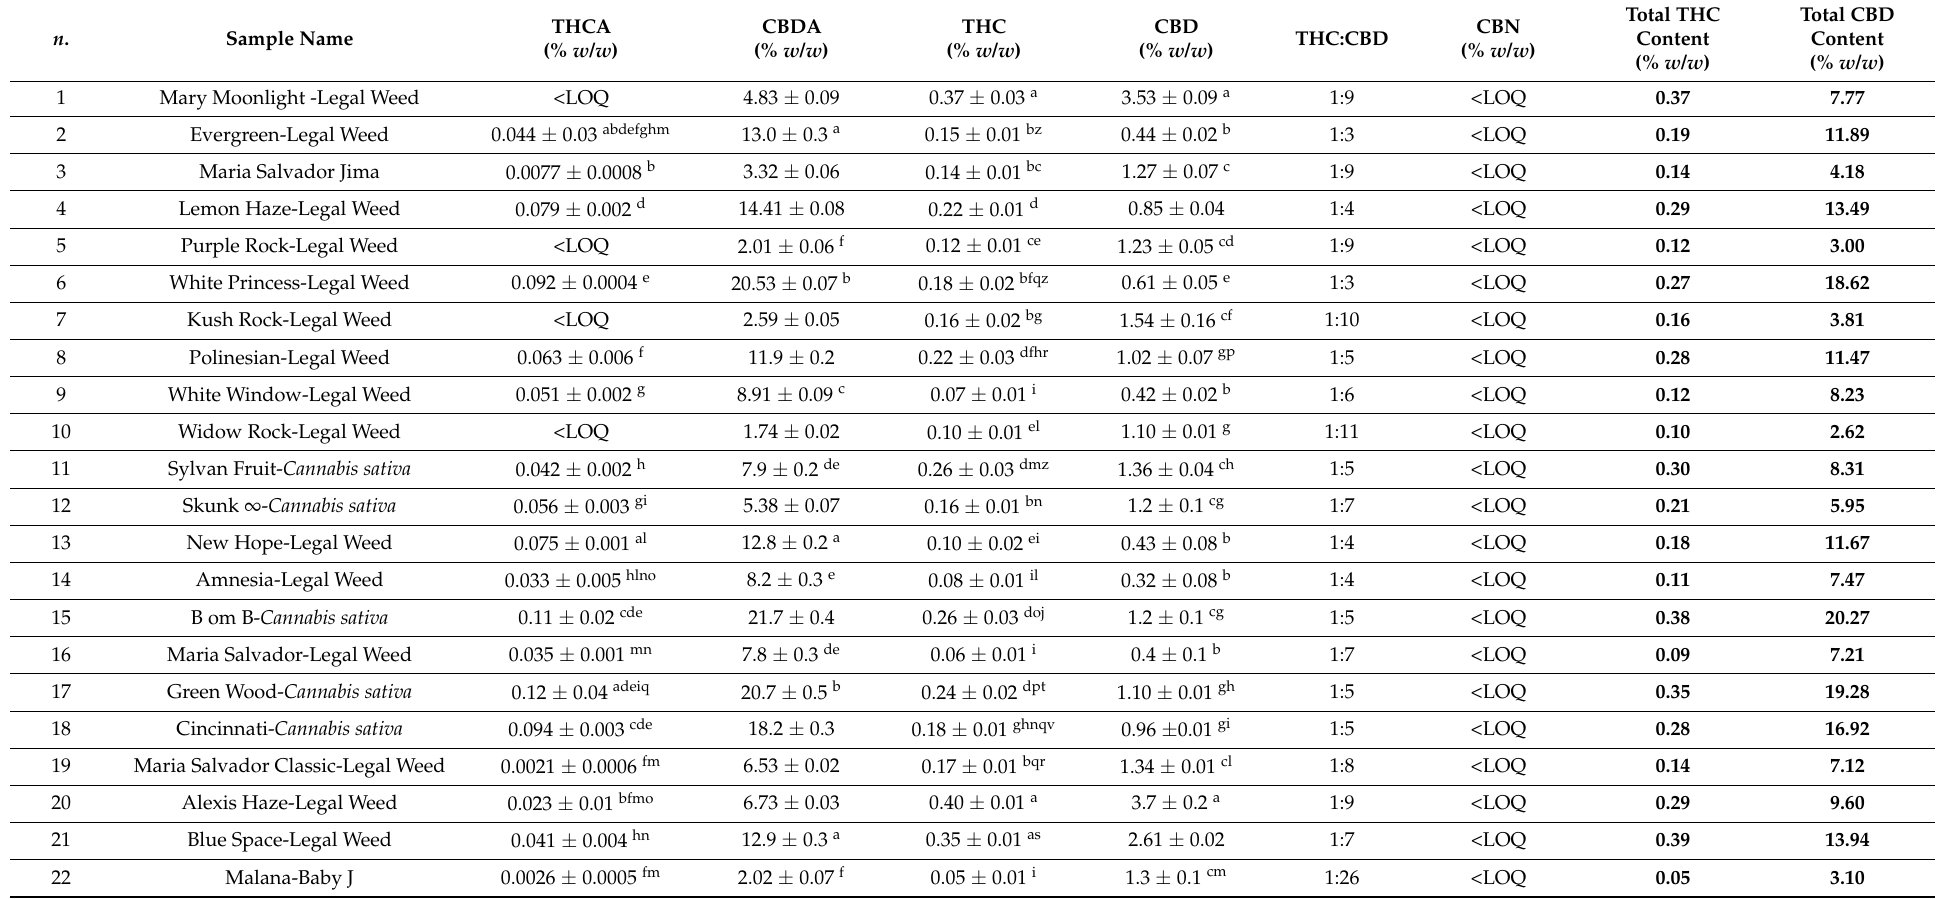
Table 3. Cannabinoid contents, THC, CBD, THCA, CBDA, total THC, total CBD, and CBN, expressed as % ( w / w ) ± standard deviation ( n = 3 replicates), for 34 Cannabis sativa L. samples of industrial hemp. Values marked by the same letter are not significantly different ( p < 0.05). n